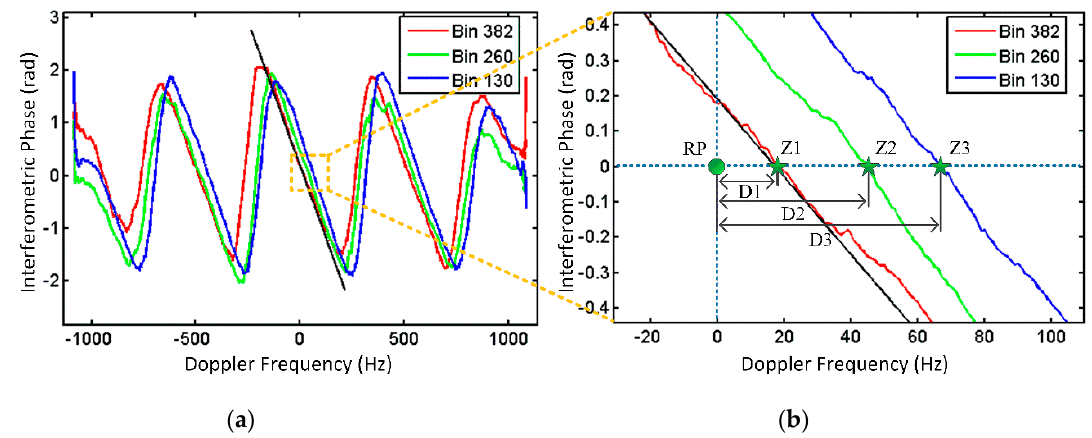
Figure 4. Curves for the three range bins. ( a ) The phase curves of the 130th, 260th, and 382nd range bins. ( b ) The partially enlarged curves of ( a ).